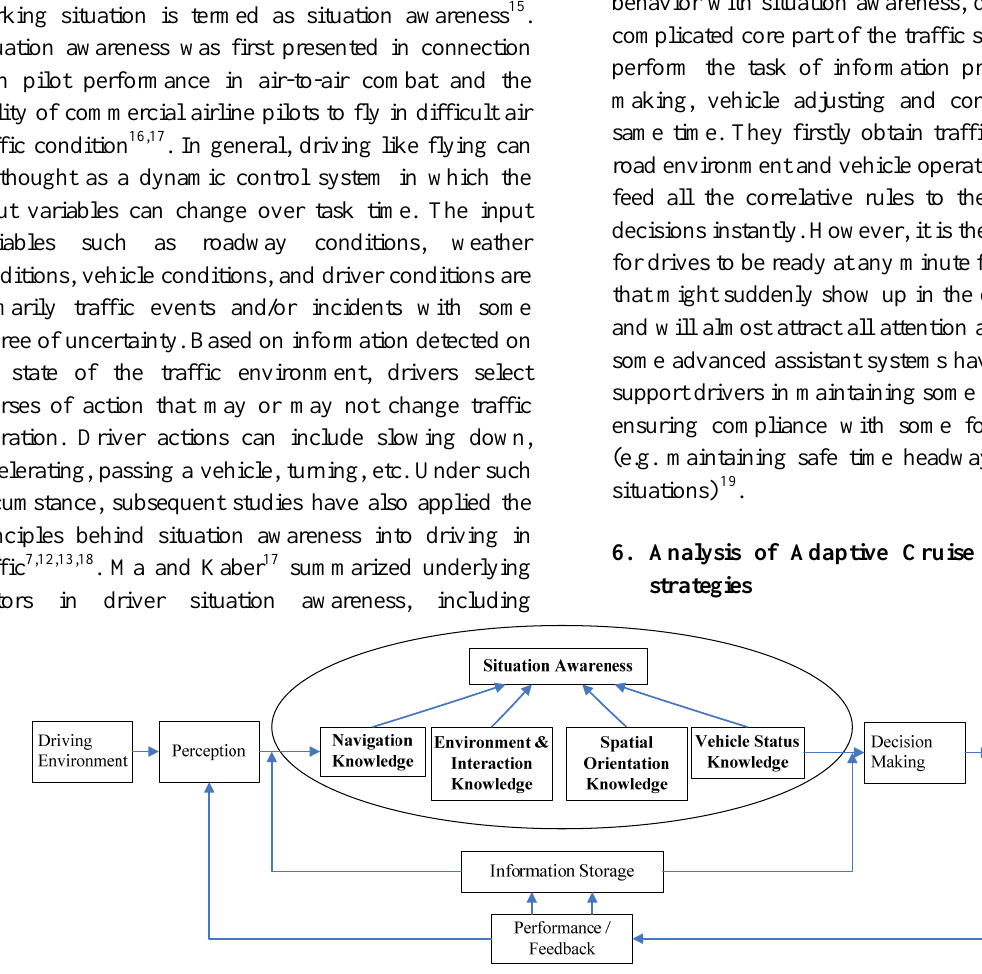
Fig.4. Driver situation awareness in traffic operation